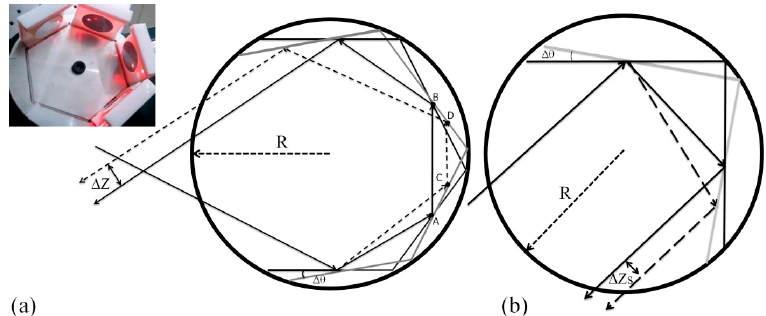
Figure 1. Parallel shift light paths before and after the angular variation. ( a ) Hexagonal mirror; ( b ) Square mirror.